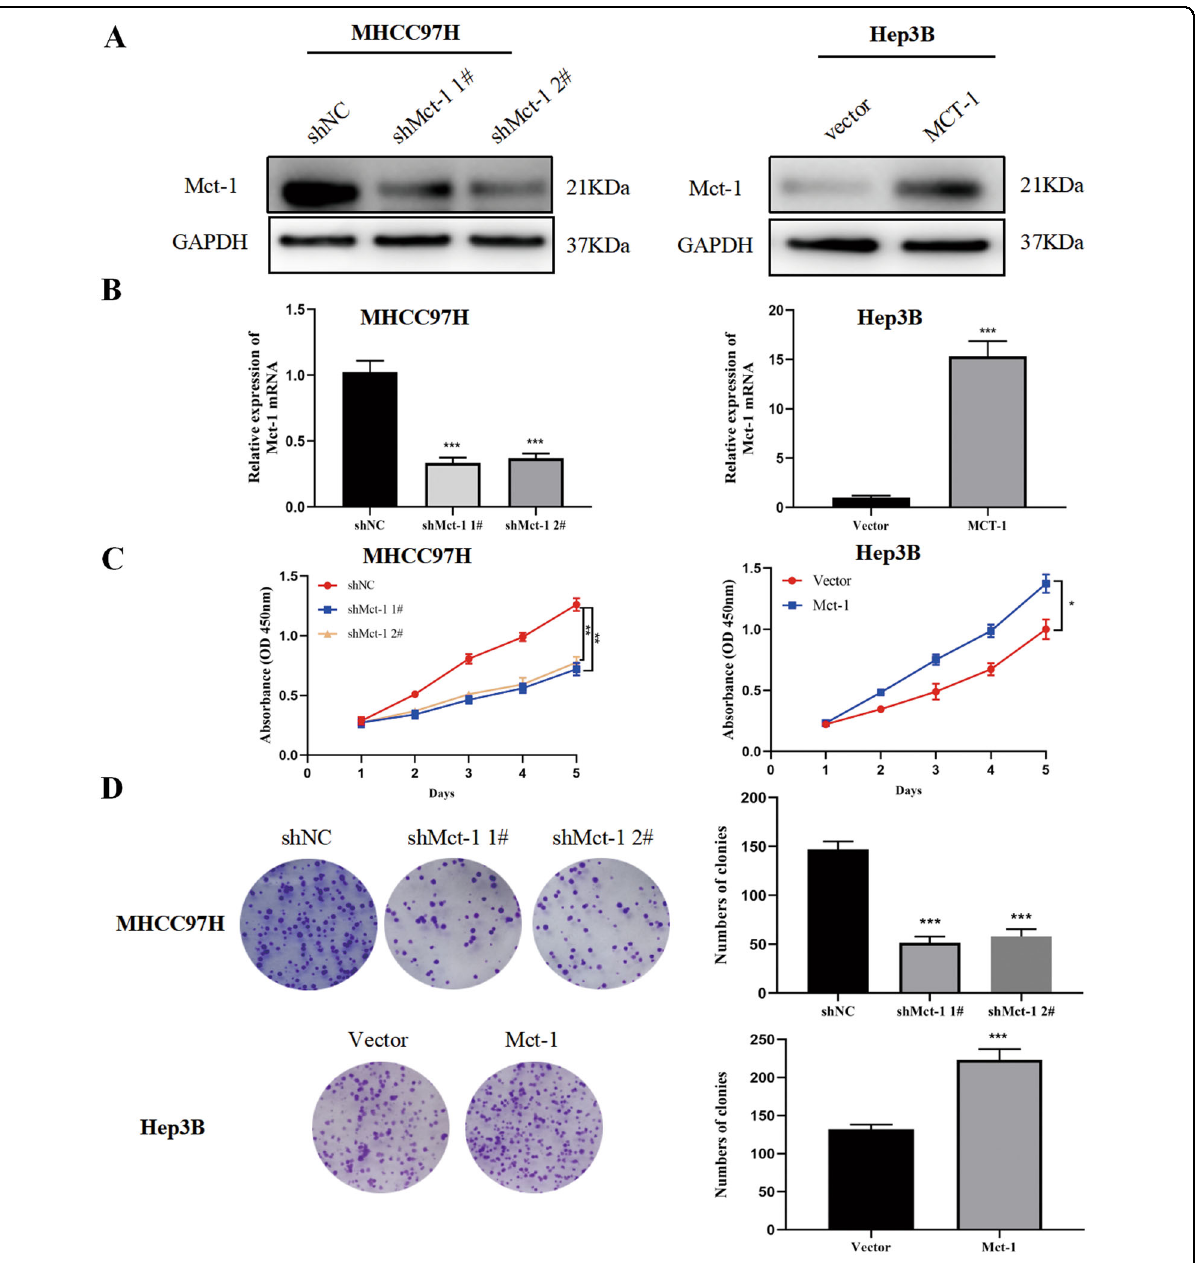
Fig. 3 Mct-1 has potent oncogenic functions in HCC. MHCC97H cells transfected with shRNA targeting Mct-1 were de fi ned as shMct-1. Cells transfected with empty lentiviral vectors were established as negative controls (shNC). Hep3B cells were transfected with lentiviruses overexpressing Mct-1 and de fi ned as Mct-1. Cells transfected with empty lentiviral vectors were used as controls (Vector). Mct-1 expression was validated by western blot ( A ) and qRT-PCR ( B ) analyses. C The CCK-8 assay results of MHCC-97H and Hep3B cells following silencing or overexpression of Mct-1. D Colony formation assay results of MHCC-97H and Hep3B cells after knockdown or overexpression of Mct-1. The data are presented as the mean ± standard deviation (SD) of experiments performed in triplicate. * p < 0.05, ** p < 0.01, *** p <